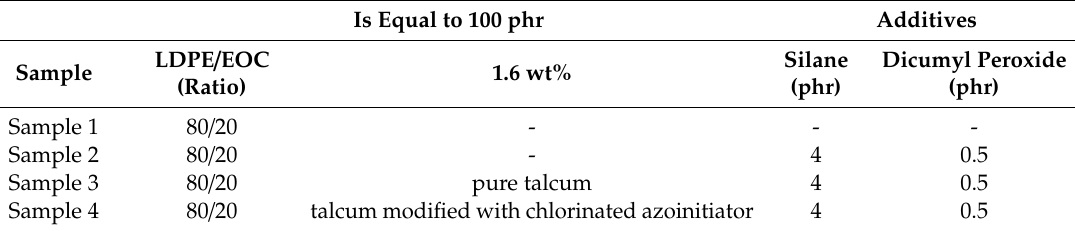
Table 1. Used material formulations for crosslinking